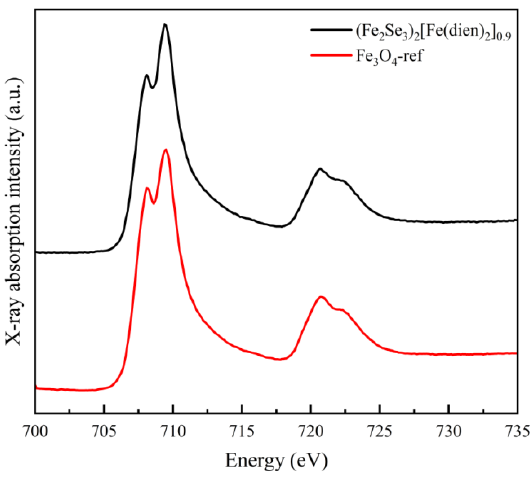
Figure 5. XAS of the (Fe 2 Se 3 ) 2 [Fe(dien) 2 ] 0.9 hybrid rods and Fe 3 O 4 as reference. The main peak of Fe L 3 -absorption edge is at 710 eV with lower shoulder at 708 eV, and the main peak of Fe L 2 -absorption edge is at 720 eV with higher shoulder at 722